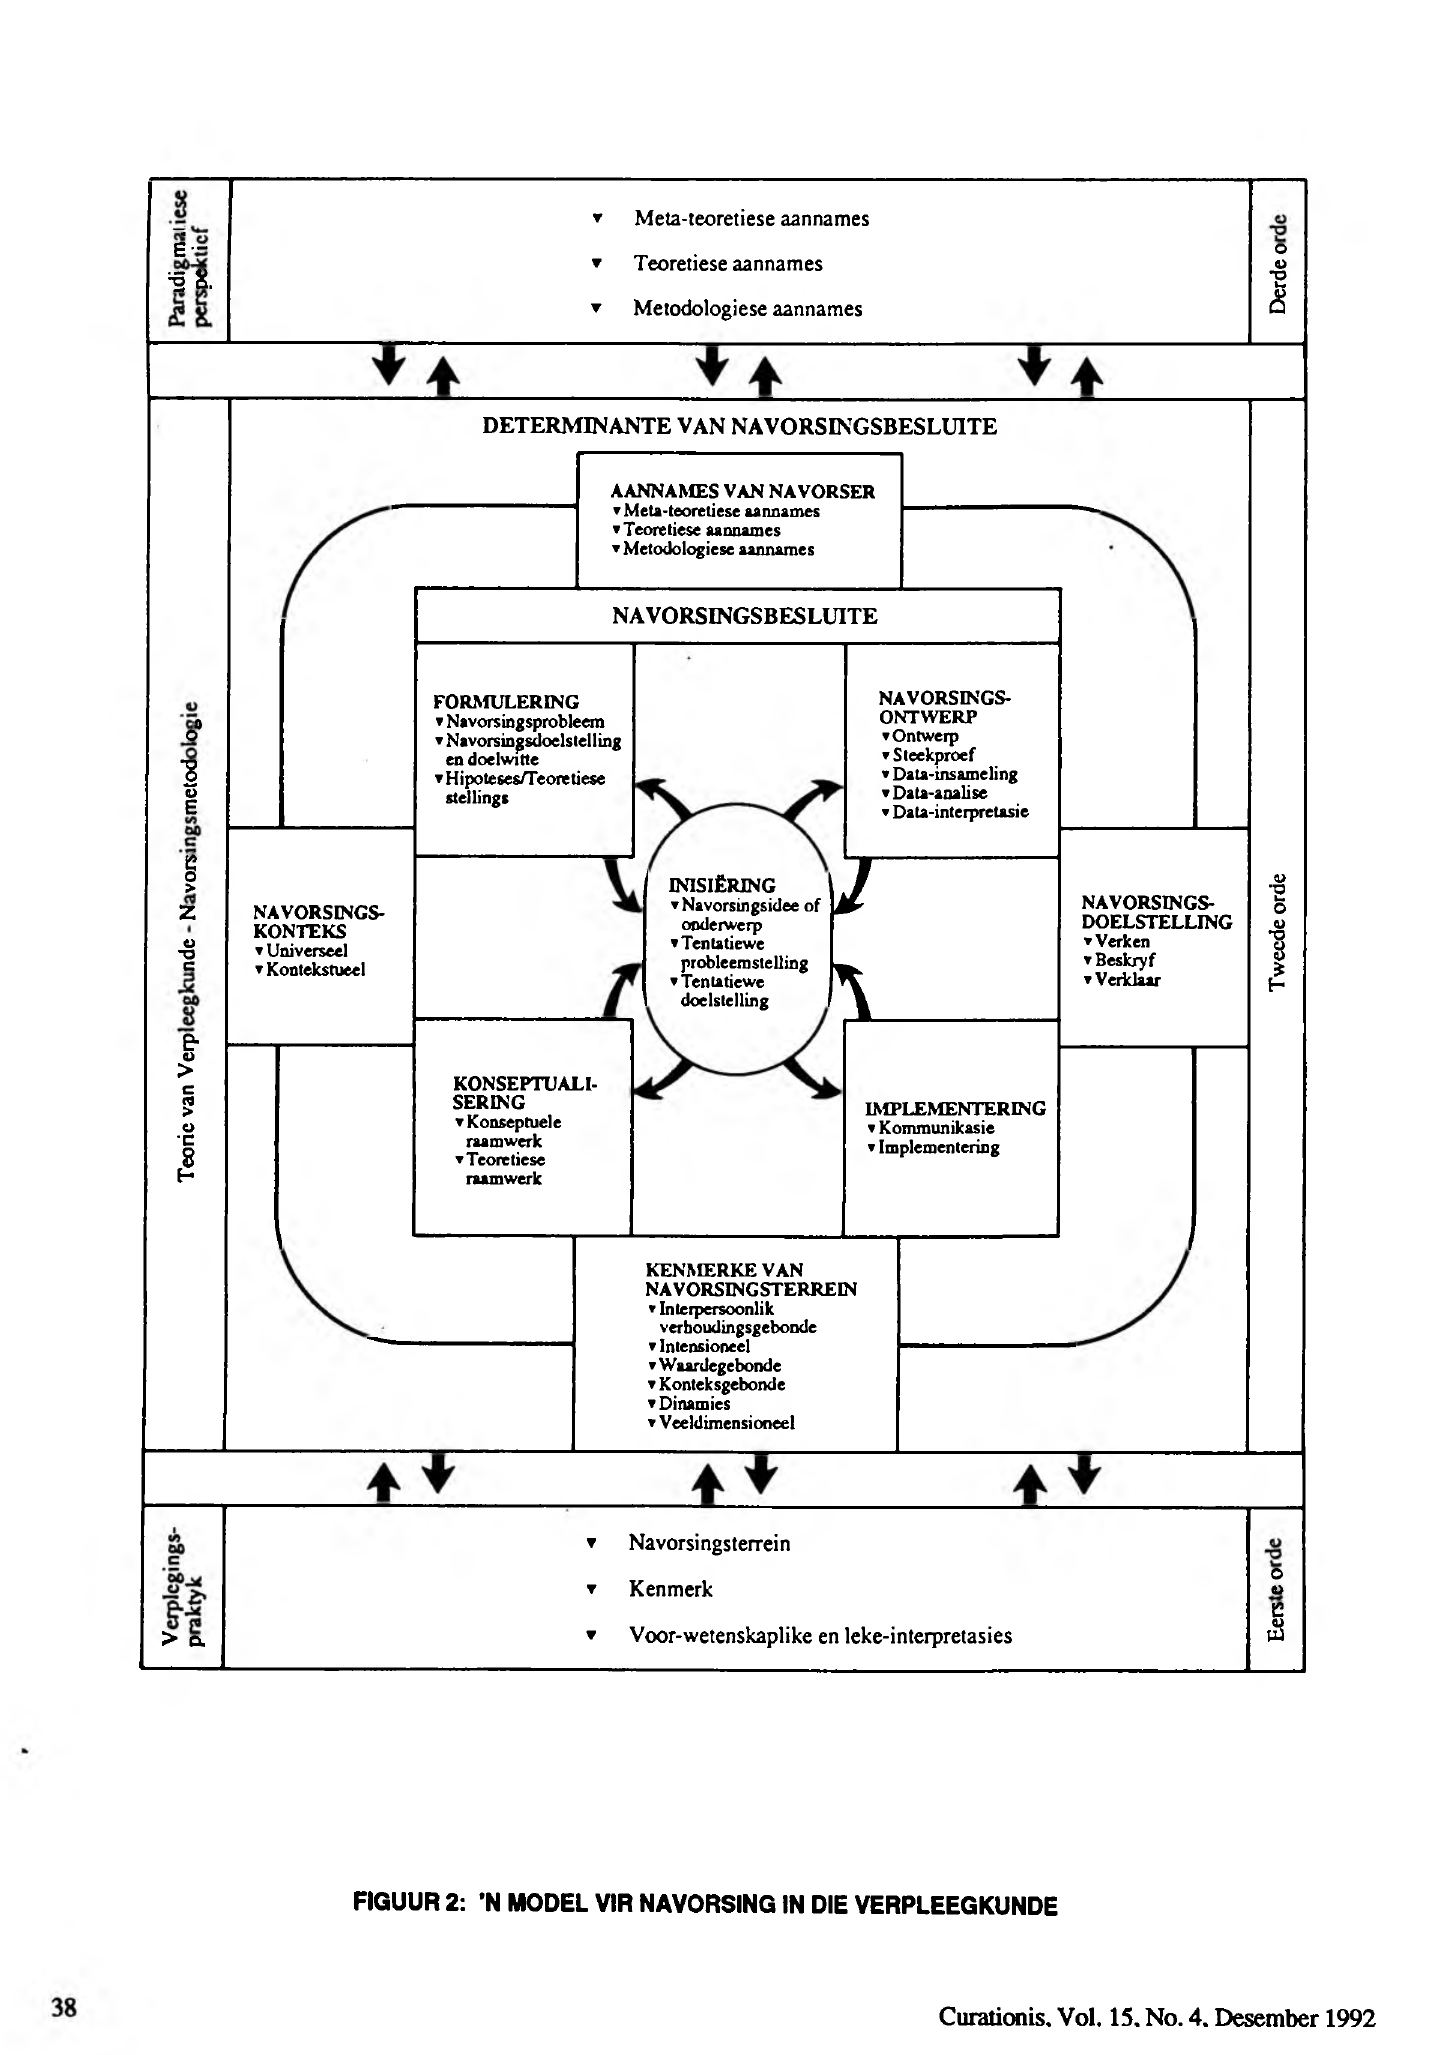
Curationis. Vol. 15. No. 4. Desember